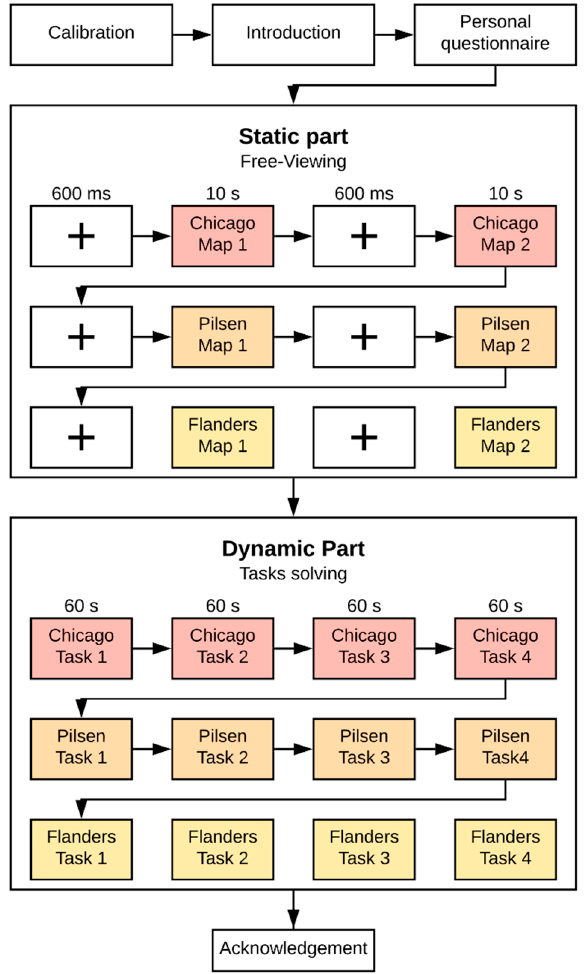
Figure 1. Scheme of the experiment.